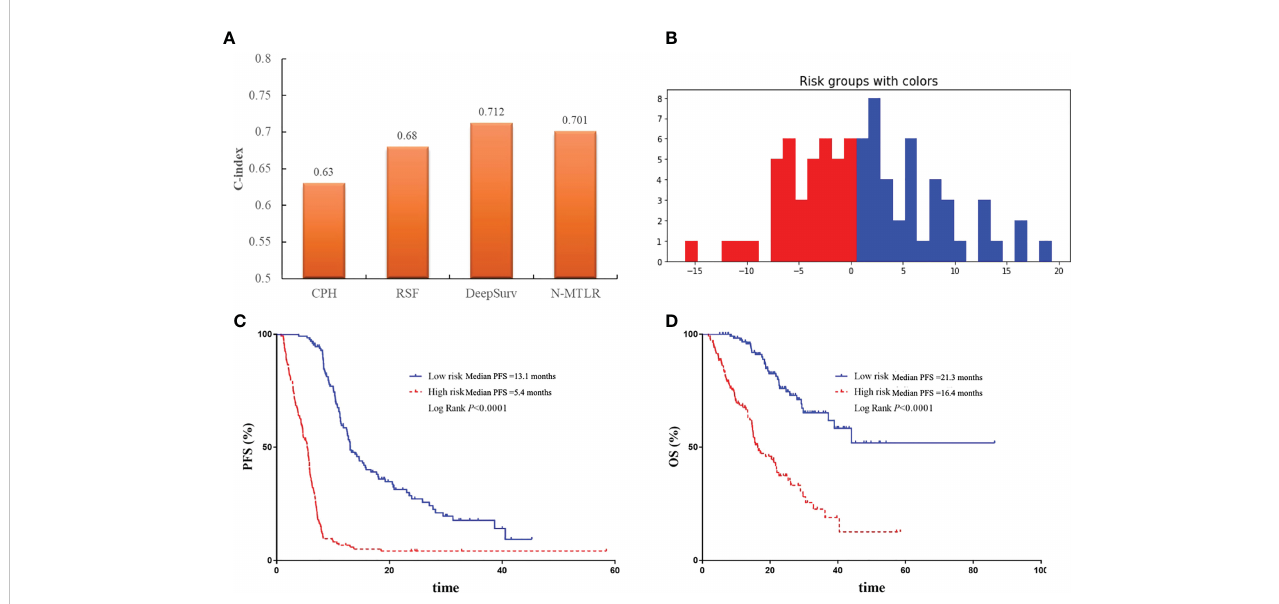
FIGURE 5 The comparison and validation of the performance of DeepSurv models. (A) The comparison of performance of machine learning and deep learning models. (B) All patients were divided into high-risk and low-risk group according to DeepSurv model. (C) Comparison of Kaplan-Meier survival curves of PFS between high-risk and low-risk patients. (D) Comparison of Kaplan-Meier survival curves of OS between high-risk and low-risk patients.